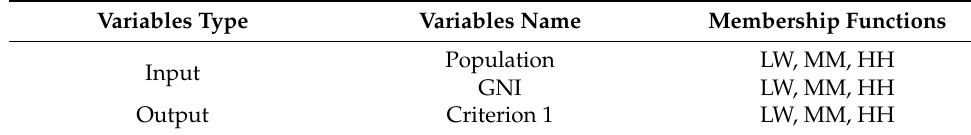
Table 6. First Type-1 fuzzy system population and GNI variables.